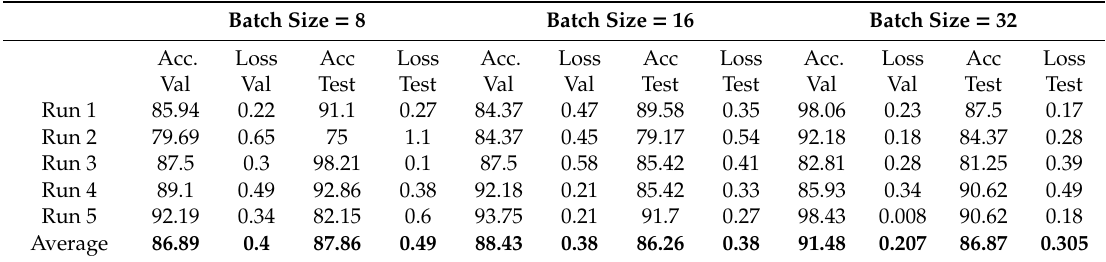
Table 4. CNN model 2 (epochs = 200, dropout = 0.7, pixel = 256 × 256) runs for different batch sizes.